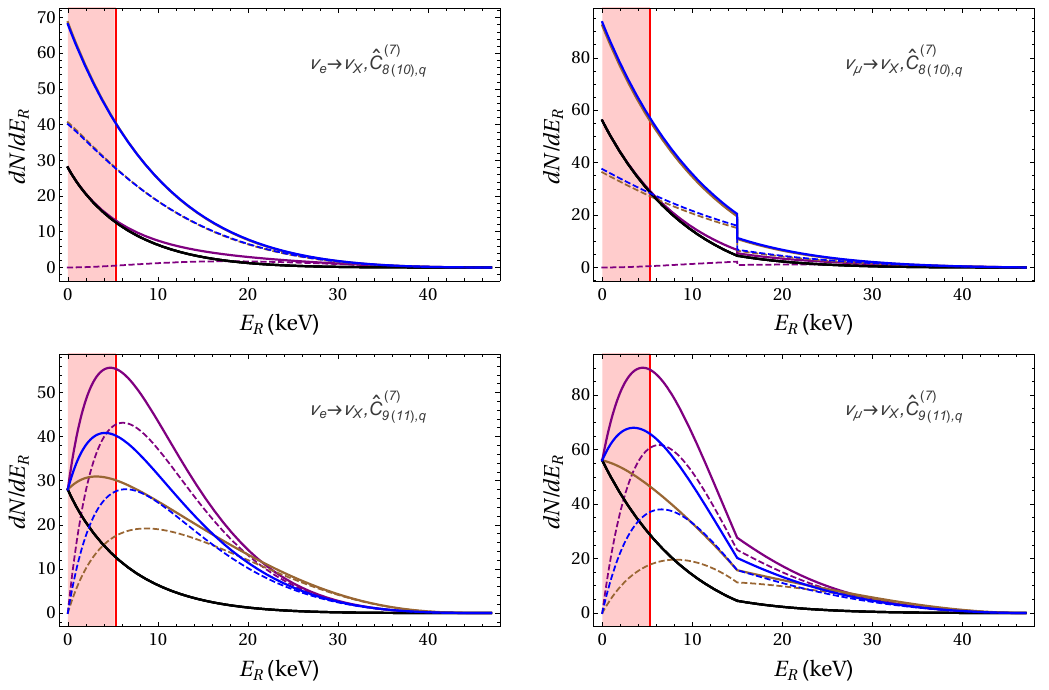
Figure 13 . Same as figure 12 but for